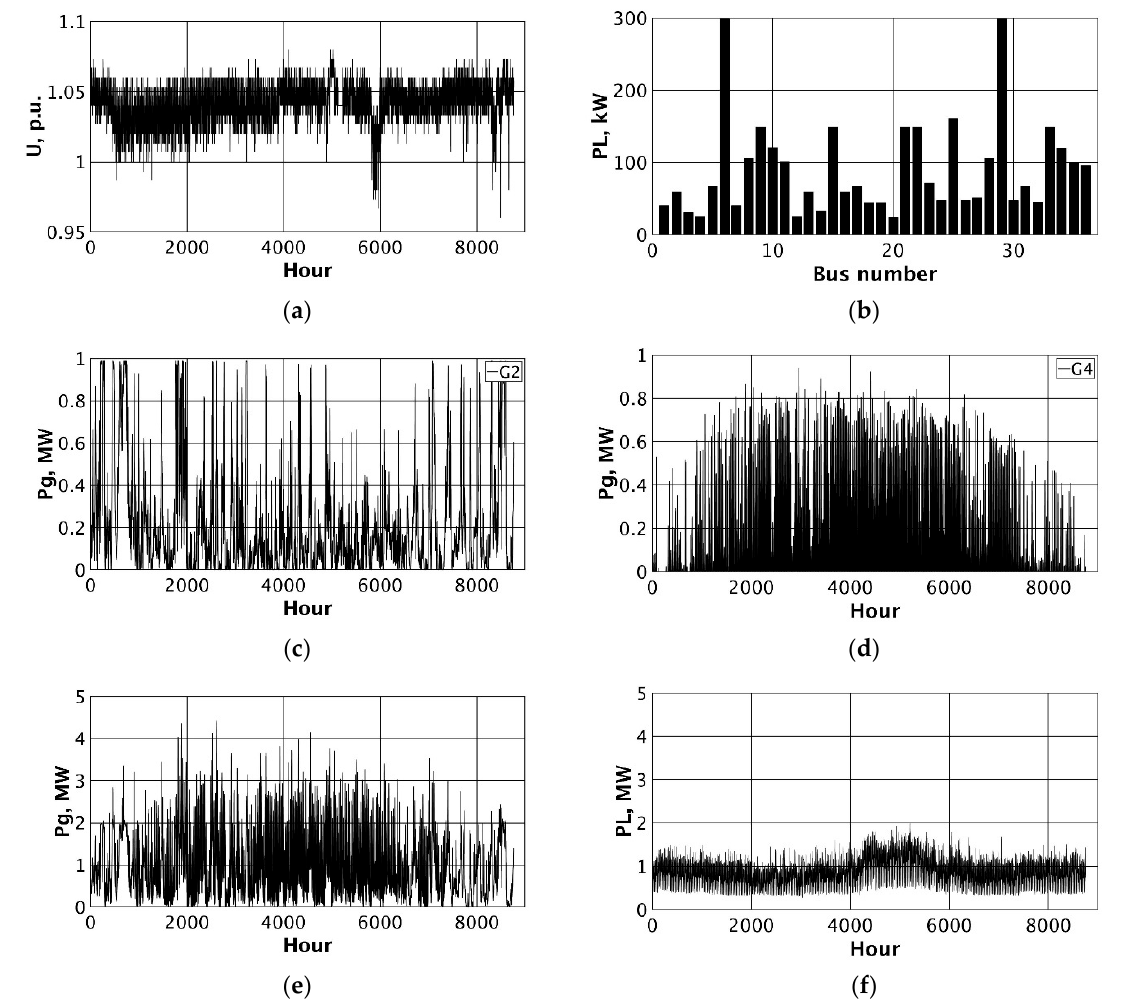
Figure 7. Drawn variable values for subsequent calculation cases ( a ) HV values, ( b ) maximum loads of individual nodes, ( c ) power generated in wind turbine (G2), ( d ) power generated in photovoltaic farm (G4), ( e ) total power generated in renewable energy sources, ( f ) total load power in MV nodes.